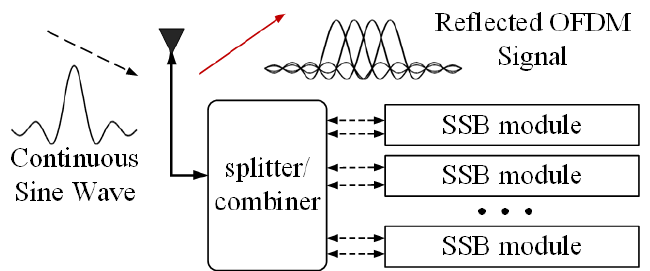
Figure 1. Structure of a multicarrier backsca tt er device.